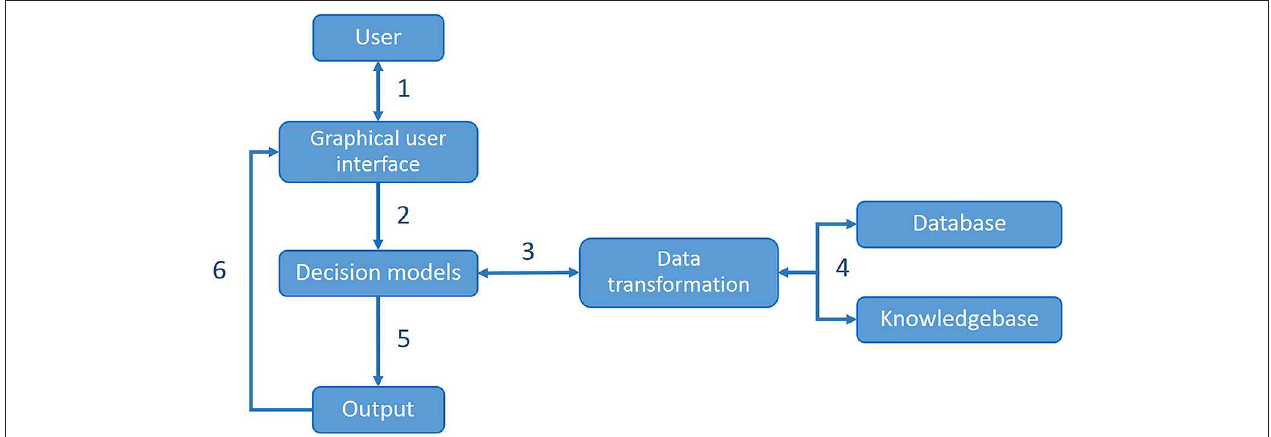
FIGURE 1 | Methodological structure of the DSS for the assessment and management of five soil